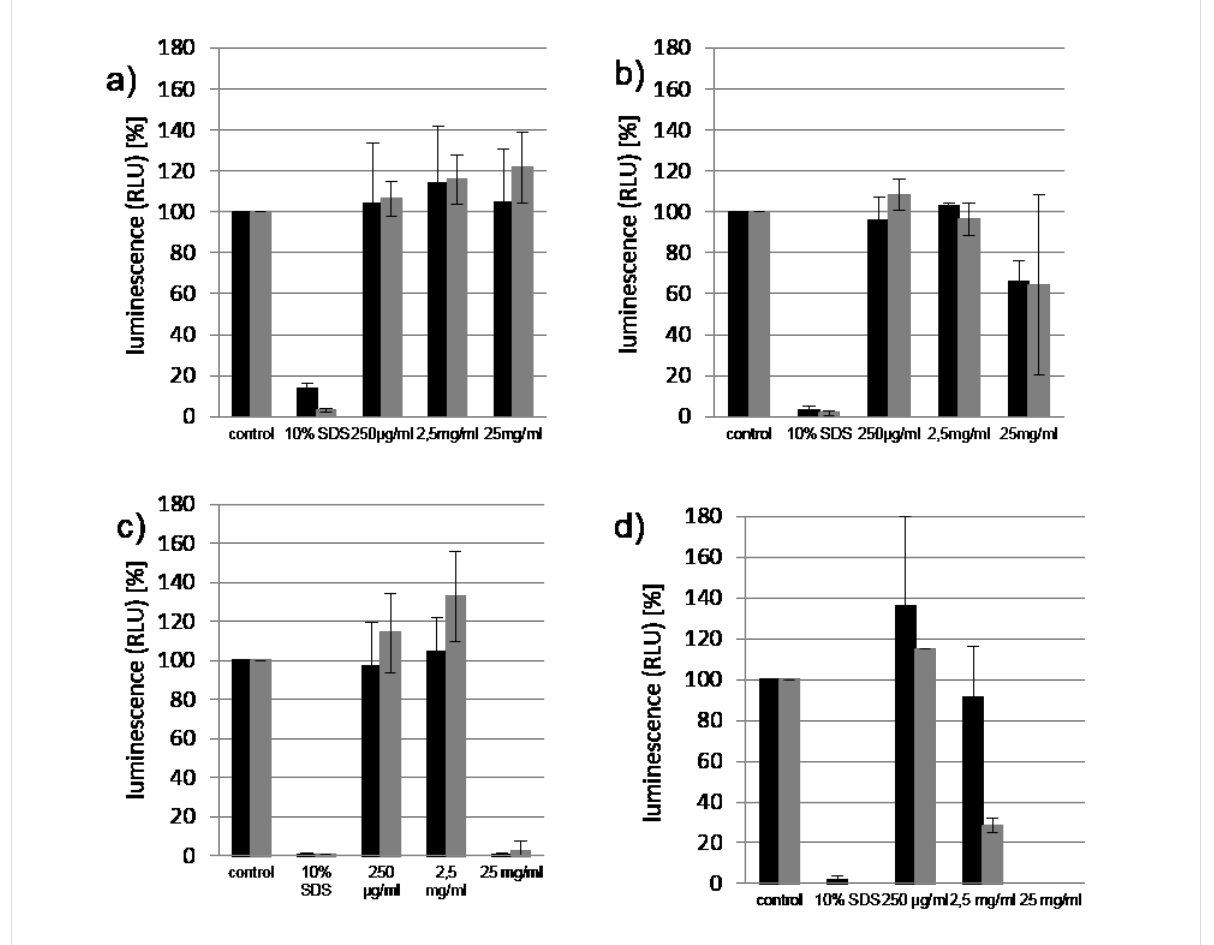
Figure 3: Viabilities of Caco-2 cells incubated with a) 5a after 2 h, b) 5a after 24 h, c) DIMEB after 2 h, d) DIMEB after 24 h, in serum (black), in basal medium (grey).